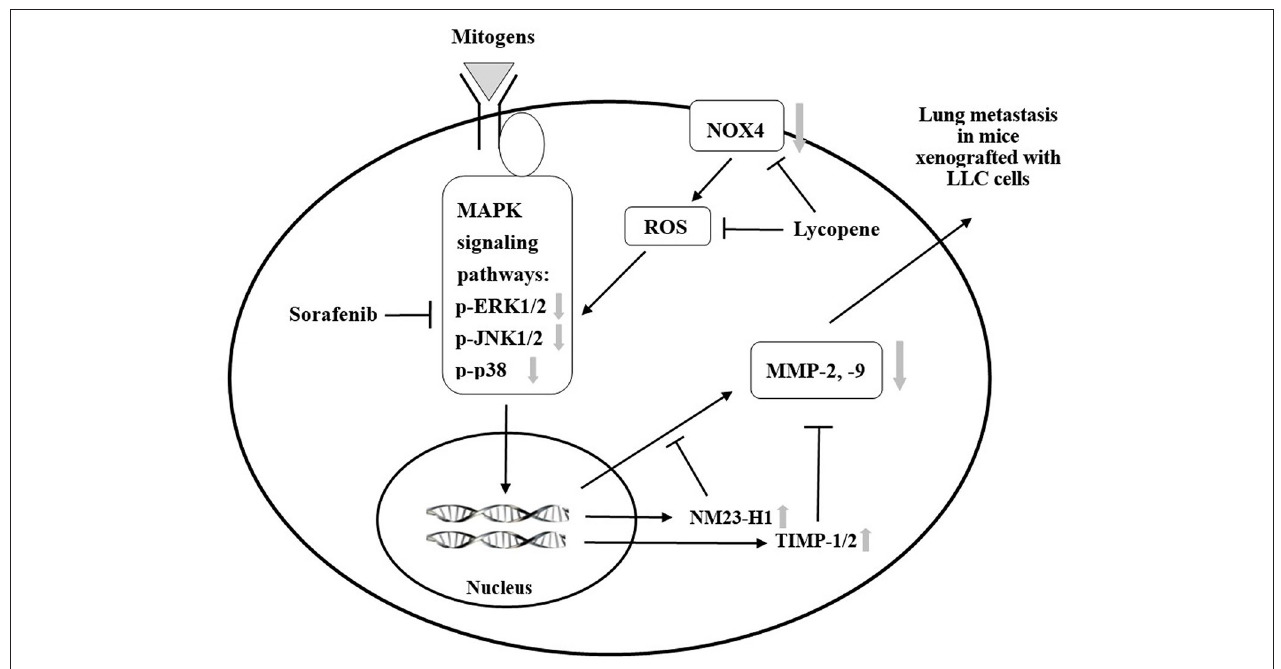
FIGURE 9 | A proposed schematic diagram for the role of mitogen-activated protein kinase (MAPK) signaling pathways in the additive effect of lycopene and sorafenib in the C57BL/6 mice xenogrfied with the Lewis lung carcinoma (LLC) cells. : inhibition; : activation or expression. : inhibition at the protein expression, phosphorylation or activity by the treatment of lycopene and sorafenib. : activation at the protein expression by the treatment of lycopene and